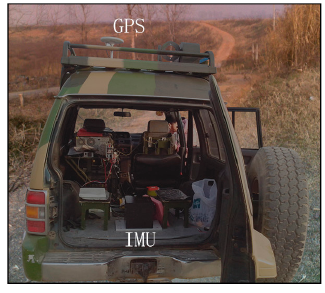
Figure 2. Test vehicle.